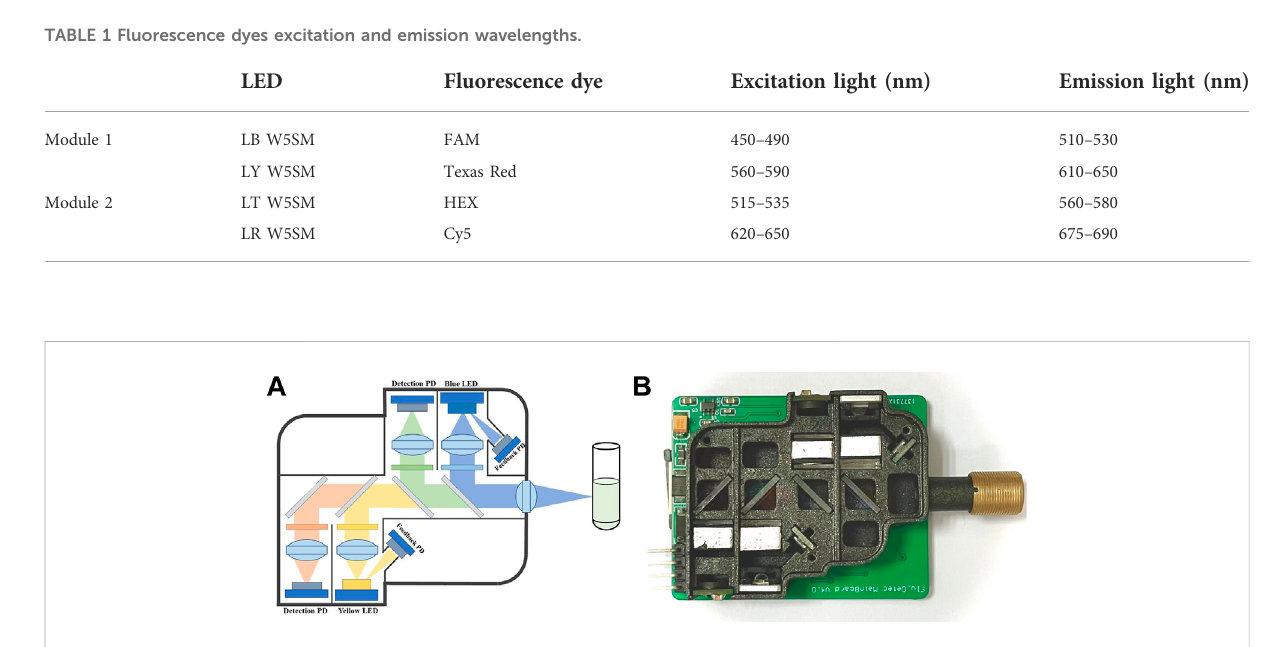
FIGURE 3 Optical path of the dual-channel fl uorescence module (Take module 1# as an example). (A) Schematic diagram of optical path: two excitation lights(blueandyellow)andtwoemittedlights(greenandorange)formsaconfocallightpathwiththehelpoffourdichroicmirrors. (B) Photographof the optical path, consistent with the